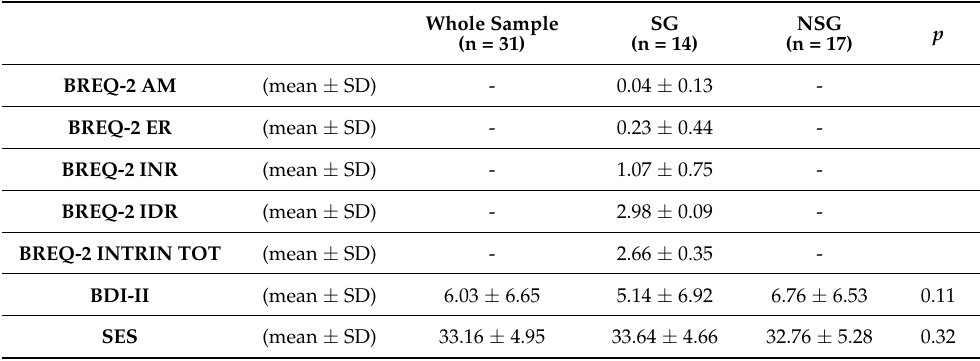
Table 2. Motivational effects of physical activity performance, depression, and self-esteem of whole sample and for each group.